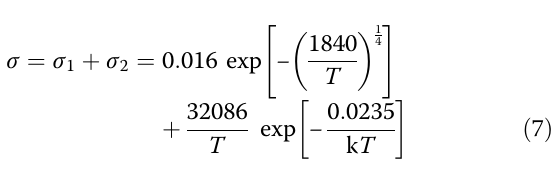
Fig. 5 a The I-V curves with a temperature of 10 K to 300 K at intervals of 10 K. b The resistance versus temperatures. c A plot of ln σ as a function of T -1/4 and a fit to the NRH model when T < 100 K. d The plot of conductivity σ as a function of T when T > 100